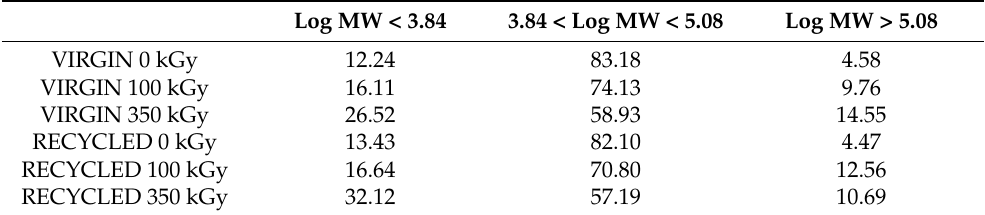
Table 3. Mass fractions for the sections split by the vertical dashed lines illustrated in Figure 10. Expressed as percentages.